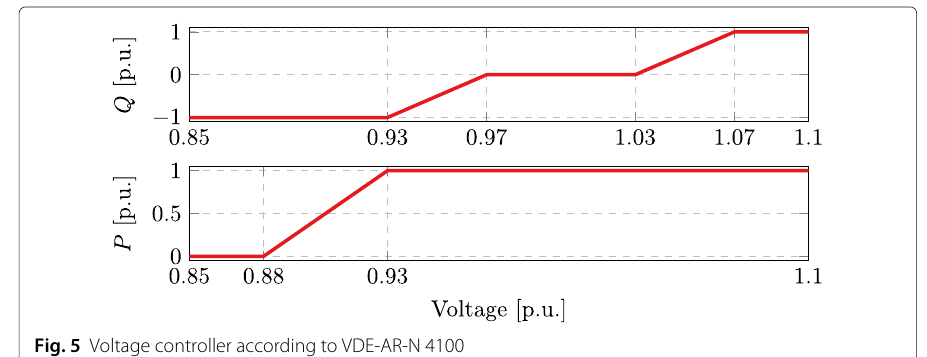
Fig. 5 Voltage controller according to VDE-AR-N